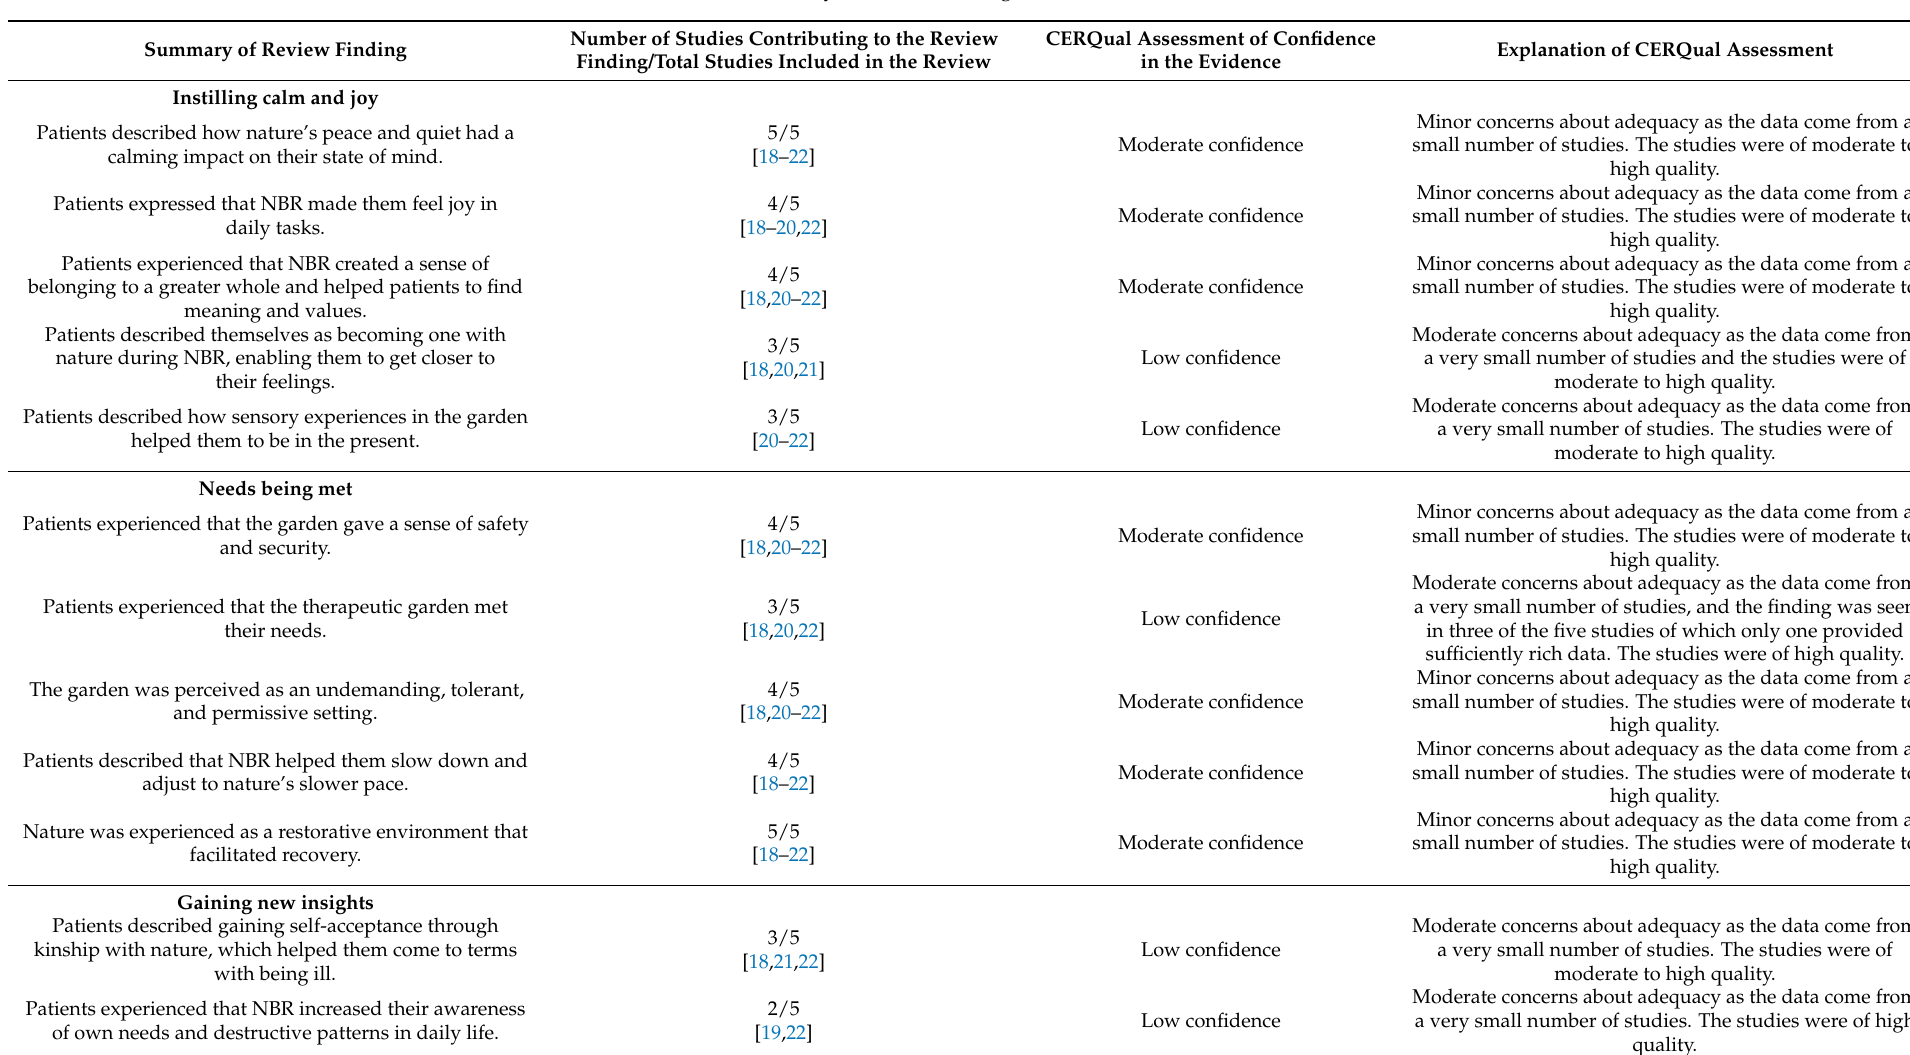
Table 3. Summary of review findings and CERQual